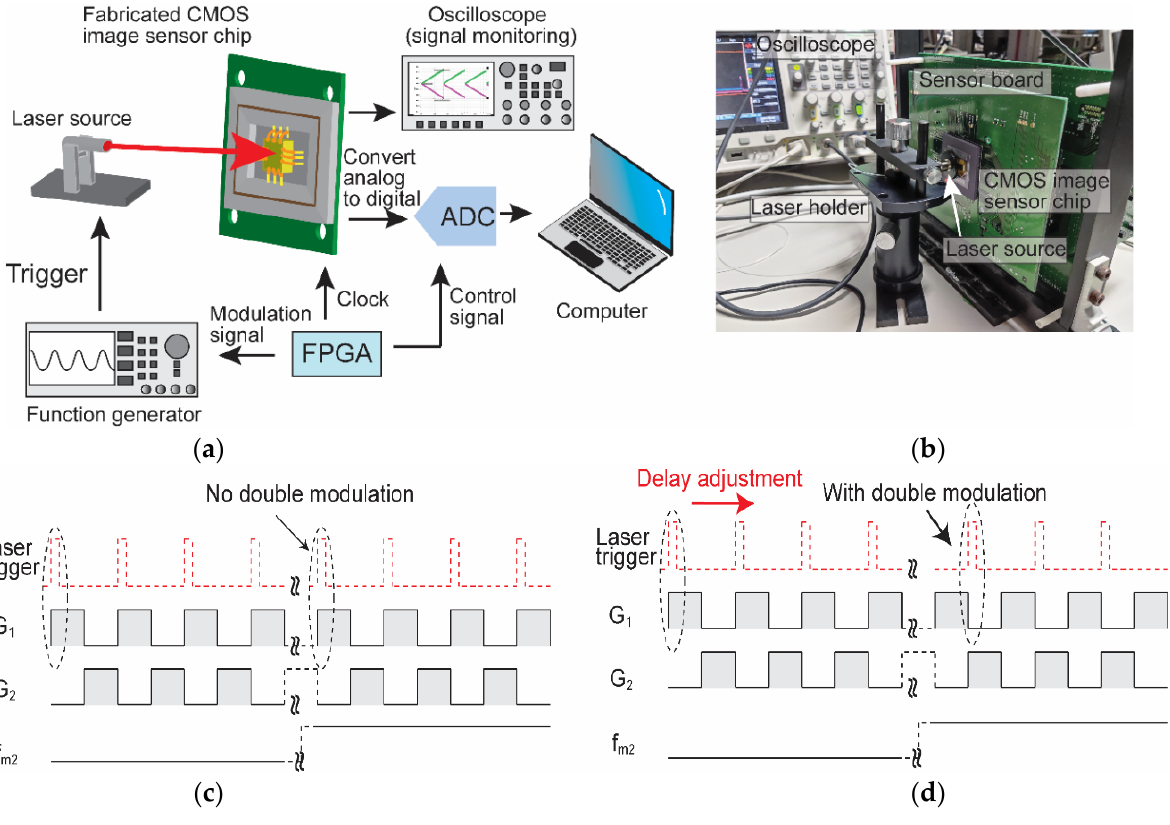
Figure 11. ( a ) The measurement setup for SRS chip evaluation. ( b ) The photograph of the chip on the sensor PCB is illuminated with a laser for chip evaluation. ( c ) A timing diagram to show the laser trigger is aligned to either G 1 or G 2 clock signals (aligned to the G 1 clock signal in this case). ( d ) Measurement timing diagram with double-modulation used on the laser